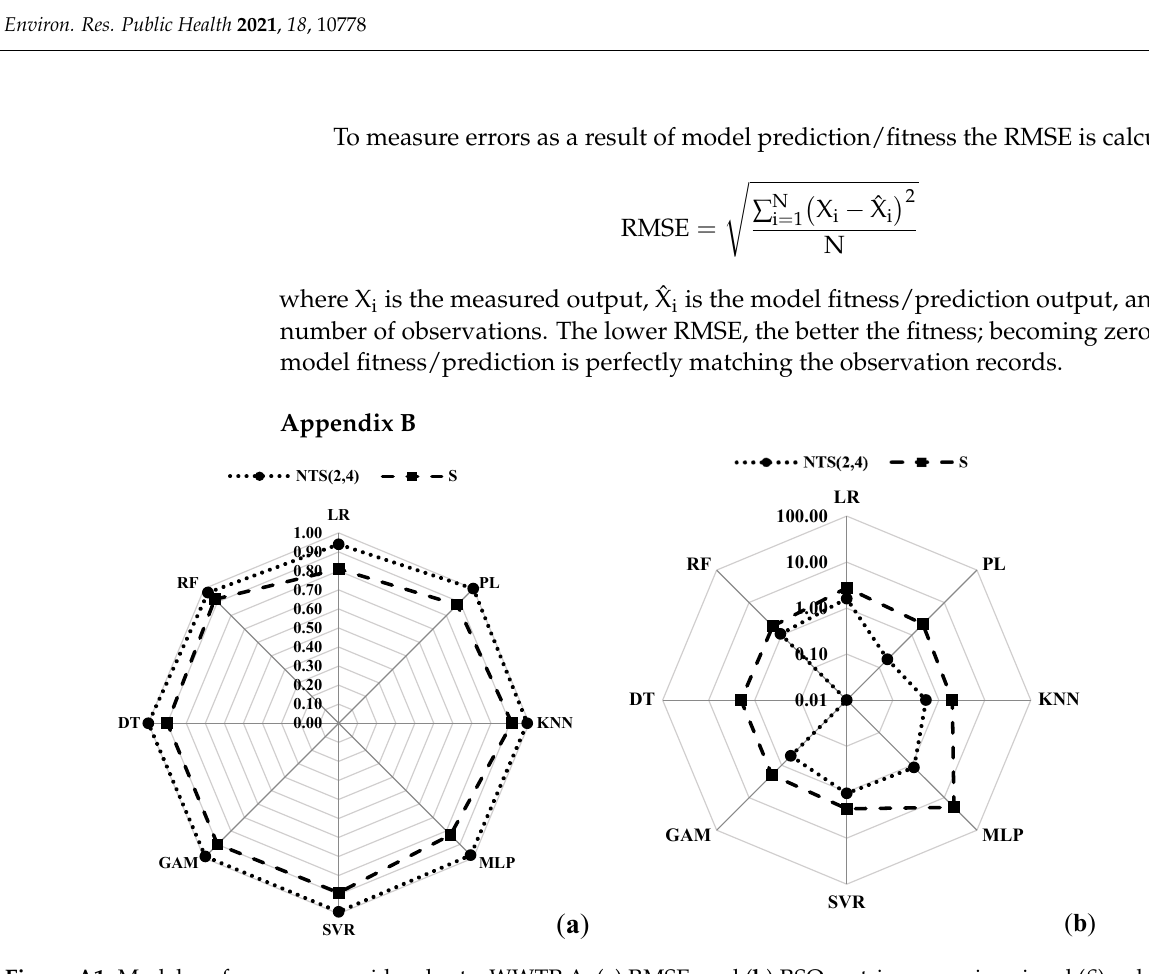
Figure A1. Model performance as spider chart—WWTP A. ( a ) RMSE, and ( b ) RSQ metric comparing signal ( S ) only with combined information of signal (S), normalisation ( N ) and tests taken ( T ).